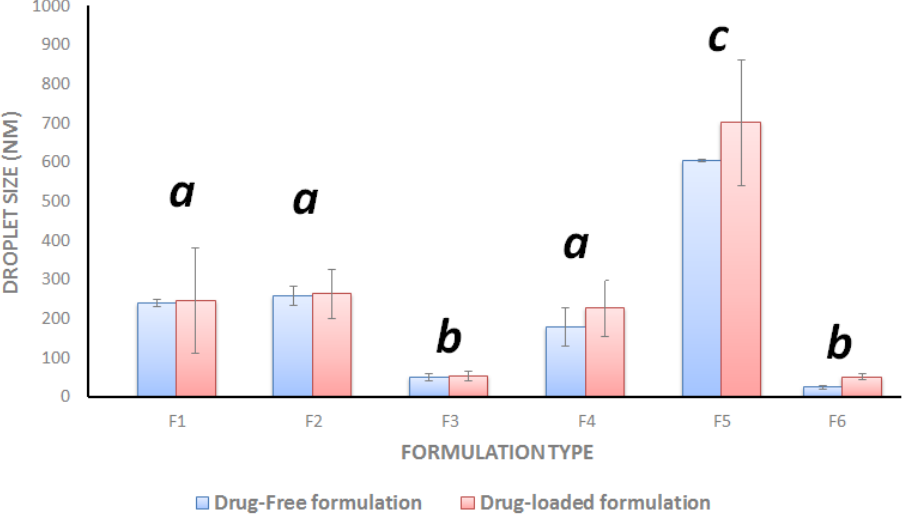
Figure 3. Influence of the drug loading on formulation droplet size. Di ff erent superscripted letters indicate statistical significance ( p < 0.05) between